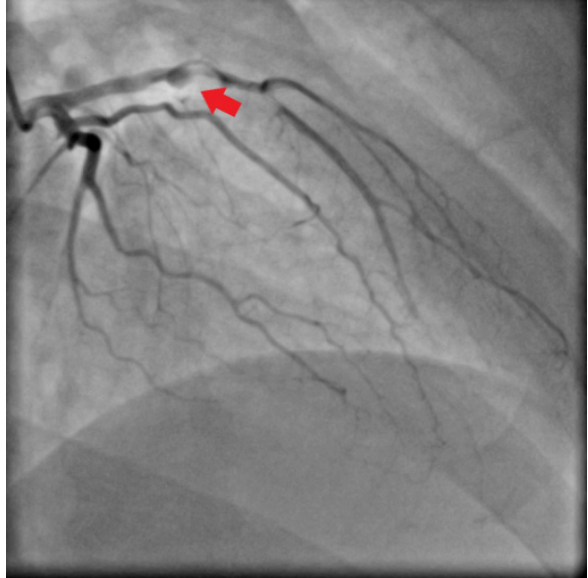
Figure 2. Another focus on thrombi in the left ventricular apex by TTE. Emergent surgical revascularization was indicated, and the patient underwent bilat- eral embolectomy of iliac, femoral, and popliteal arteries. Additional CT angiography and subsequently selective coronary angiography showed total occlusion of the left anterior descending artery with collateralization (Figure 3).